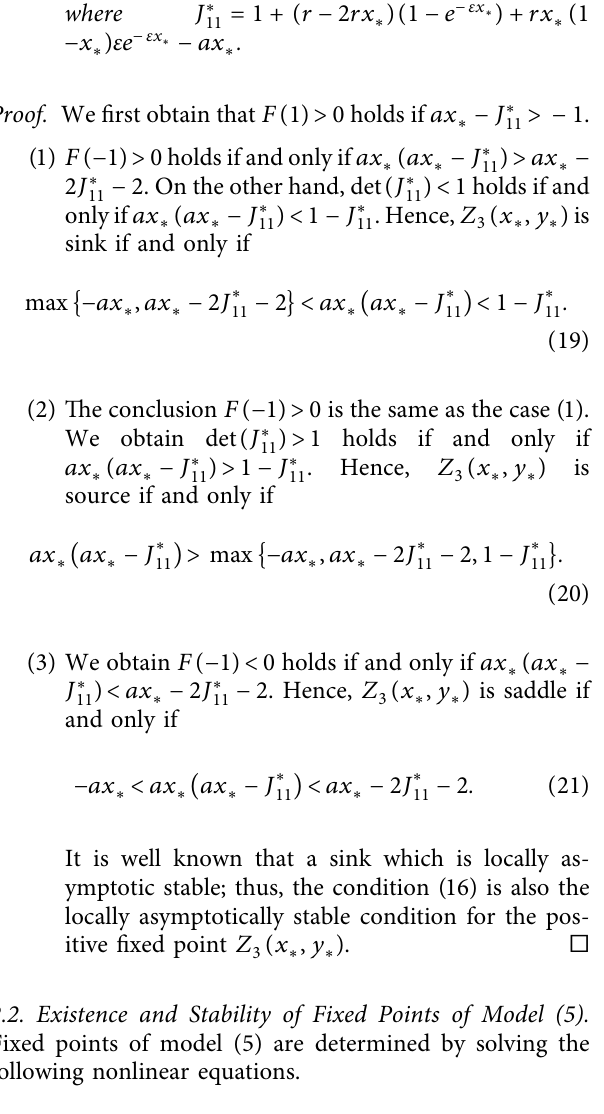
Figure 1: Te positive fxed point is given by the intersection point of the two curves ( C (a) No fxed point: r ε ≤ a and (b) unique fxed point: r ε > a